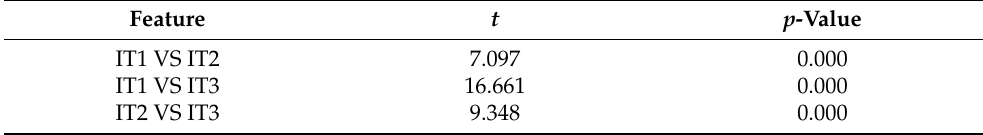
Table 5. T-test results for pairwise comparisons of the three irrigation